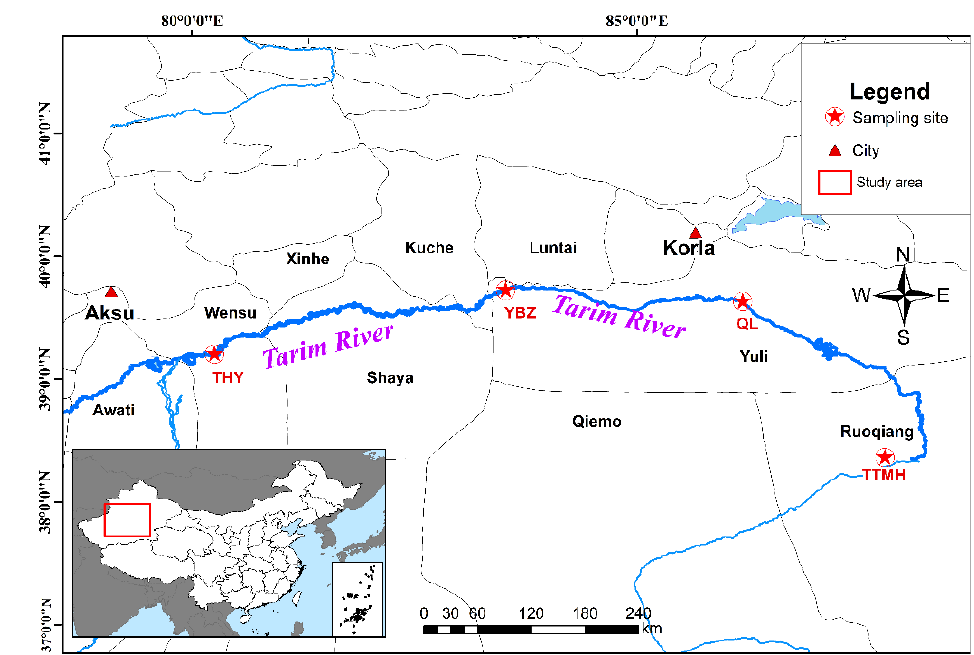
Figure 1. Sample sites of H. leucisculus in the Tarim River basin located in Xinjiang.